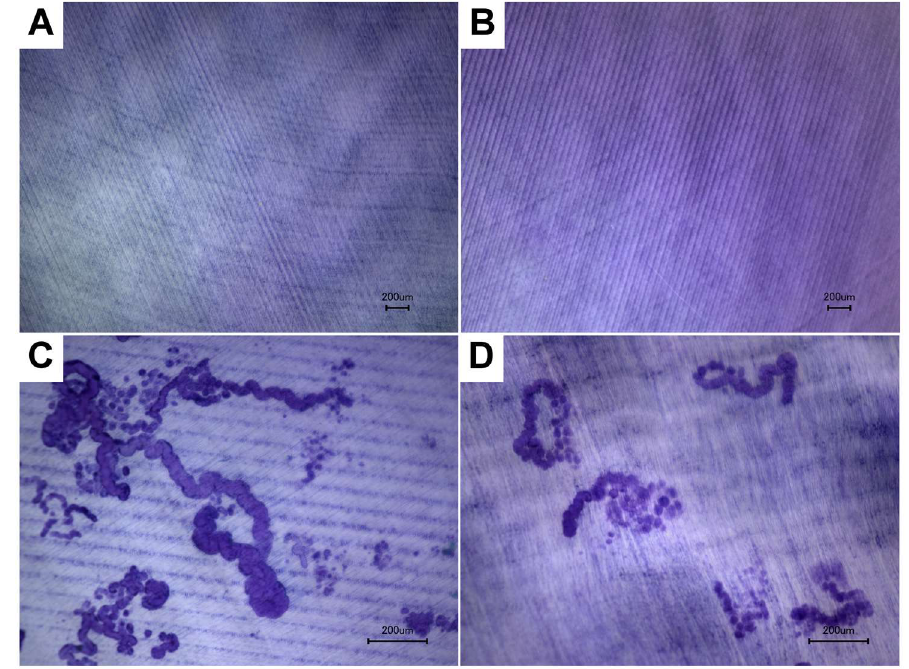
Figure 3. Resorption lacunae on dentin after staining with toluidine blue. Lack of resorption pits in monolayer PBMC/PPF co-cultures ( A ), even when cultivated in the presence of additional MCSF and RANK-L ( B ). PBMC monocultures stimulated with MCSF and RANK-L, cultivated in monolayer ( C ) or on transwell membranes (and transferred on dentin, D ), showed extensive traces of osteolysis.